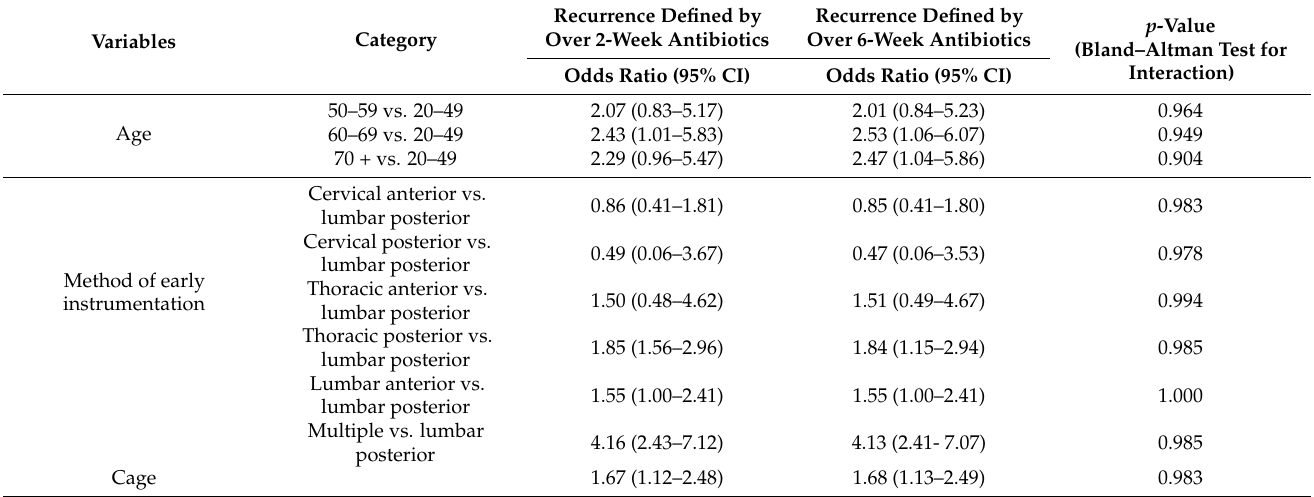
Figure 5. Factors associated with recurrence when recurrence was defined as an infection requiring over 4 weeks of antibiotic treatment: Bootstrap-adjusted odds ratios and their 95% confidence intervals (Table 5). Table 6. The assessment of potential effect modification by unknown confounders through compari- son of adjusted odds ratios across the two different definitions for recurrence: shorter ( ≥ 2 weeks) and longer ( ≥ 6 weeks) durations of antibiotic therapy for